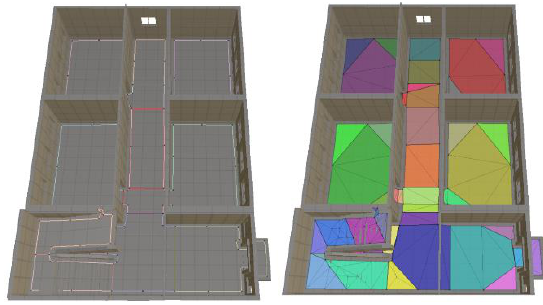
Figure 11 Contour and navigation meshes generation results